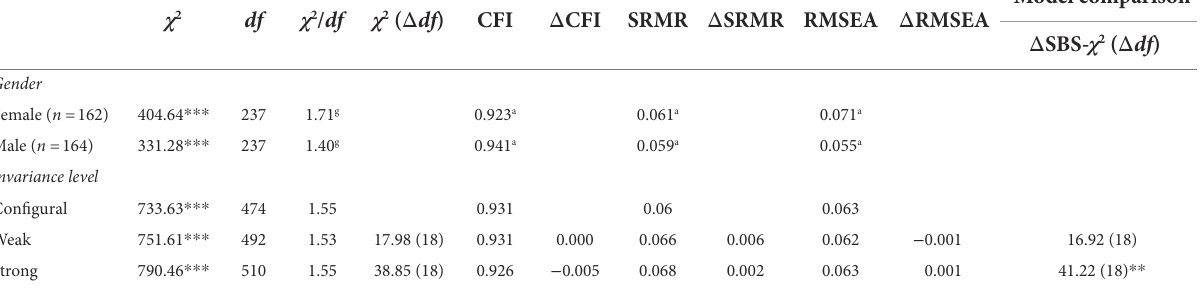
TABLE 4 Confirmatory factor analyzes for gender and invariance